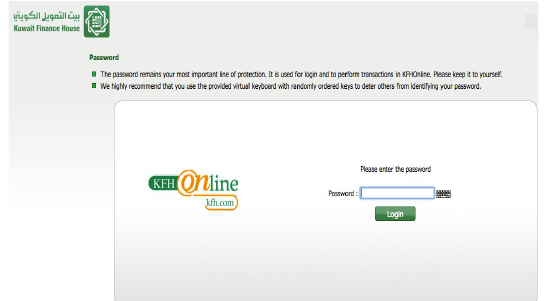
Figure 1-4: Password.